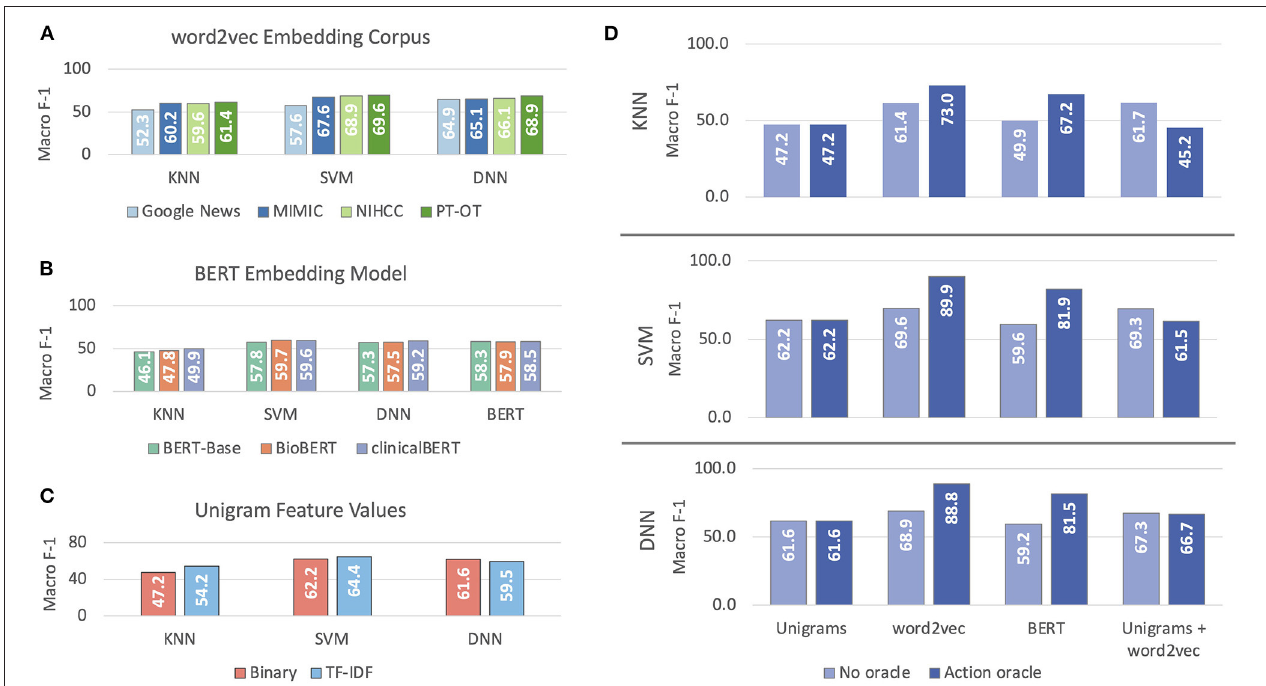
FIGURE 5 | Macro-averaged F-1 performance on classifying mobility activity reports with ICF codes or Other . Results are reported on development data. (A) reports on selection of embedding corpus for word2vec (static embeddings), (B) reports on selection of BERT model, (C) reports on selection of unigram feature weighting, and (D) reports on experiments with different feature sets, with and without the Action